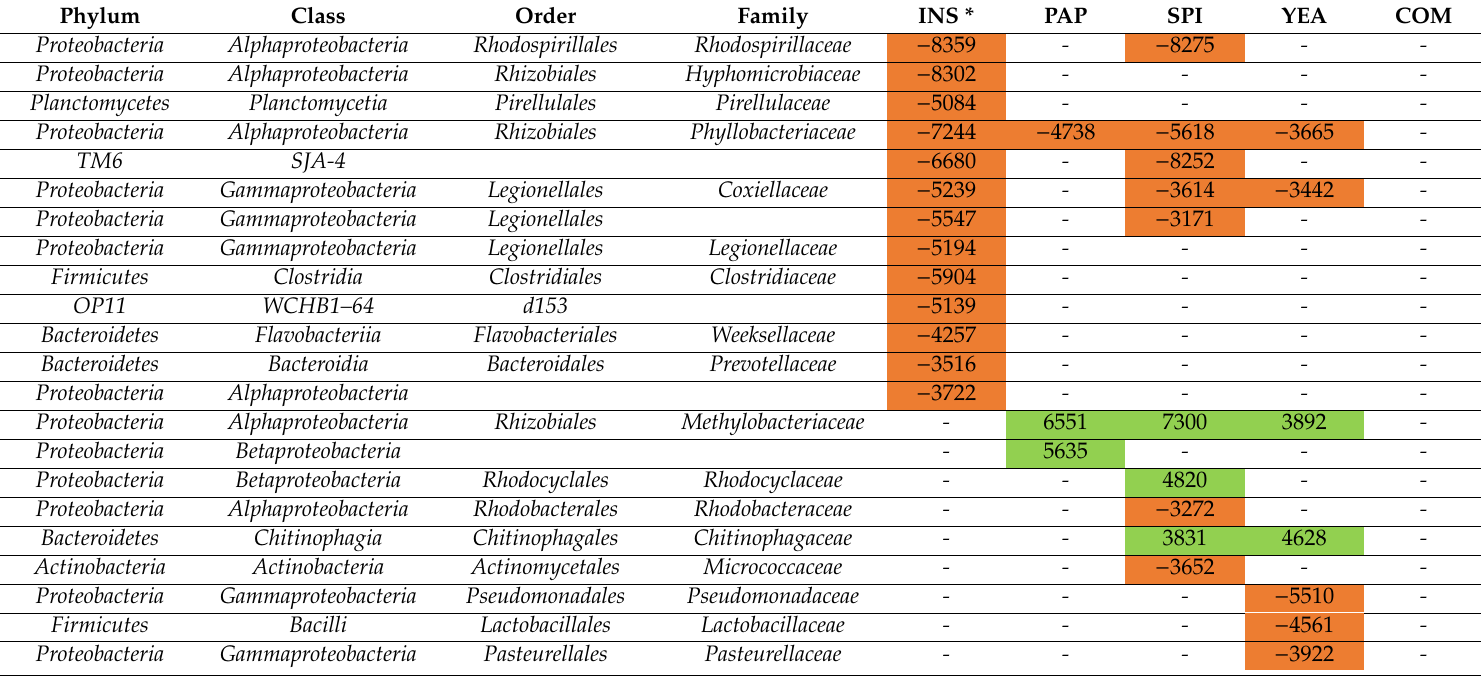
Table 2. Significantly di ff erent taxonomic groups at the family level. Significant log scaled fold-changes of di ff erentially abundant families ( p .adjust < 0.05) between experimental diets and the VEG control feed are presented (green: overabundant; orange: